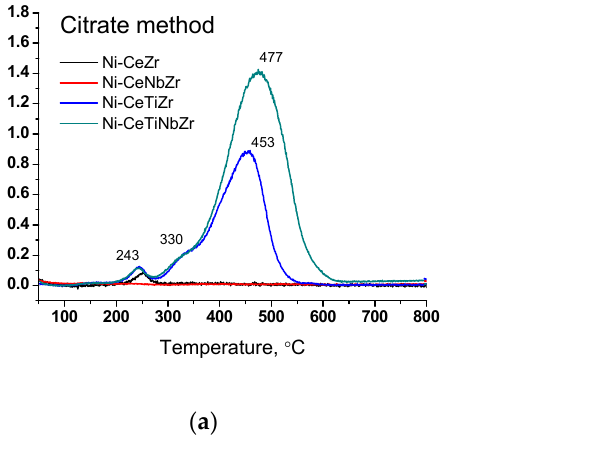
Figure 9. CO 2 concentration measured by mass-spectroscopy analysis during TGA of catalysts pre- pared by citrate method ( a ) and by supercritical synthesis ( b ) after tests in methane dry